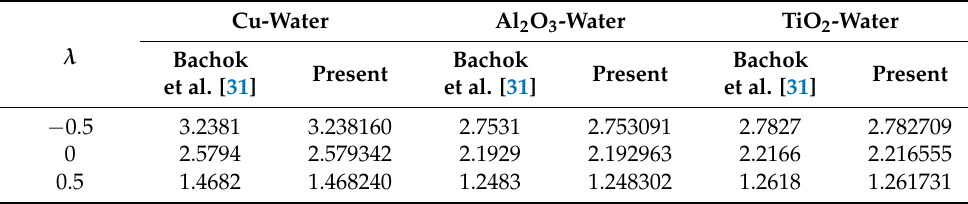
Table 3. Comparison values of C f Re 1/2 x for some values of λ when ϕ 1 = 0.1, ϕ 2 = 0 and M = 0.